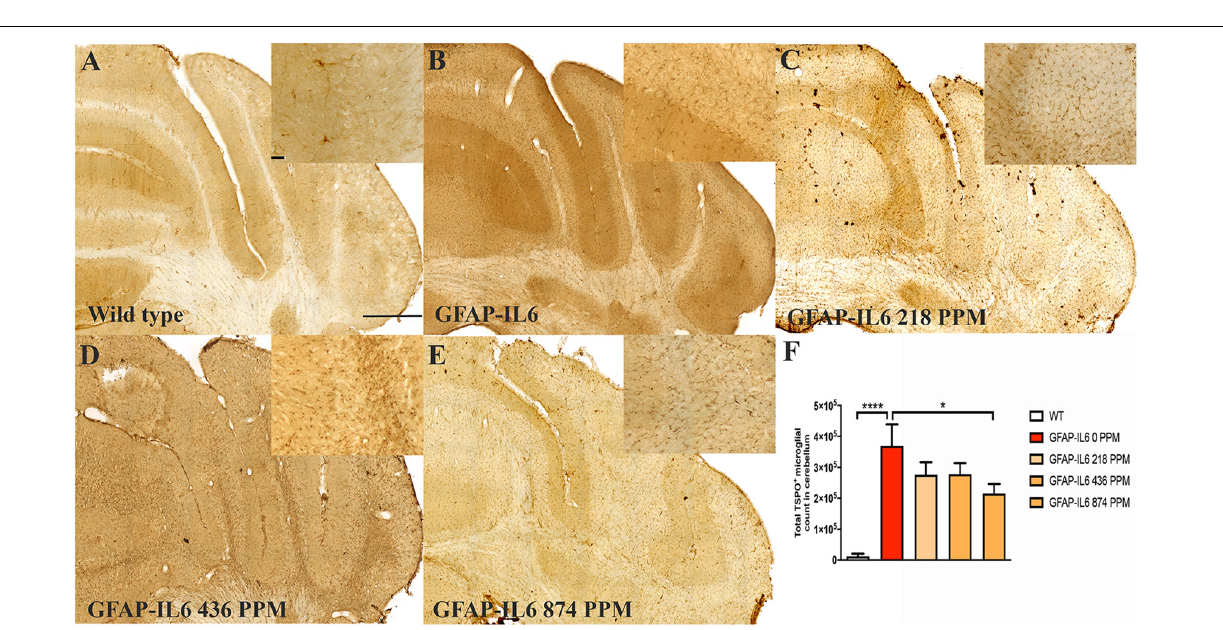
FIGURE 4 | MC decreased the number of TSPO + microglial cells/macrophages in the cerebellum of GFAP-IL6 mice. (A–E) Representative photomicrographs of immunohistochemistry staining for the microglia (TSPO + cells) of the cerebellum. (Magnification 10x objective field, scale bar = 500 µ m and 100 µ m in inserts). Images are representative of at least six animals per group ( n = 6). (F) Graphical representation of total TSPO + microglial/macrophages count in the cerebellum. The graph represents the mean ± SEM and significant differences were determined using one-way analysis of variance (ANOVA). Significance = * p < 0.01, **** p <